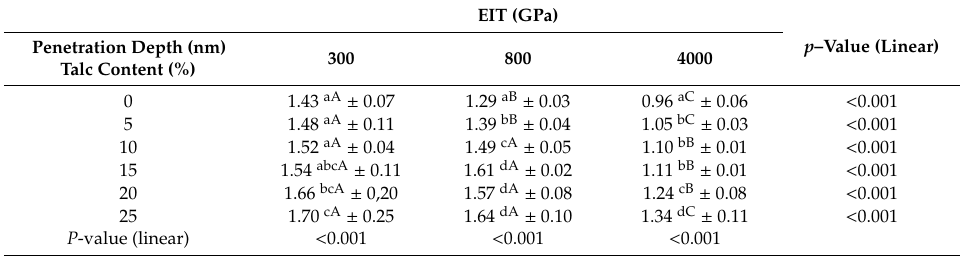
Table 2. The mean values of indentation modulus (EIT) measured for di ff erent depths with corresponding standard deviations, linear contrasts and post-hoc analysis